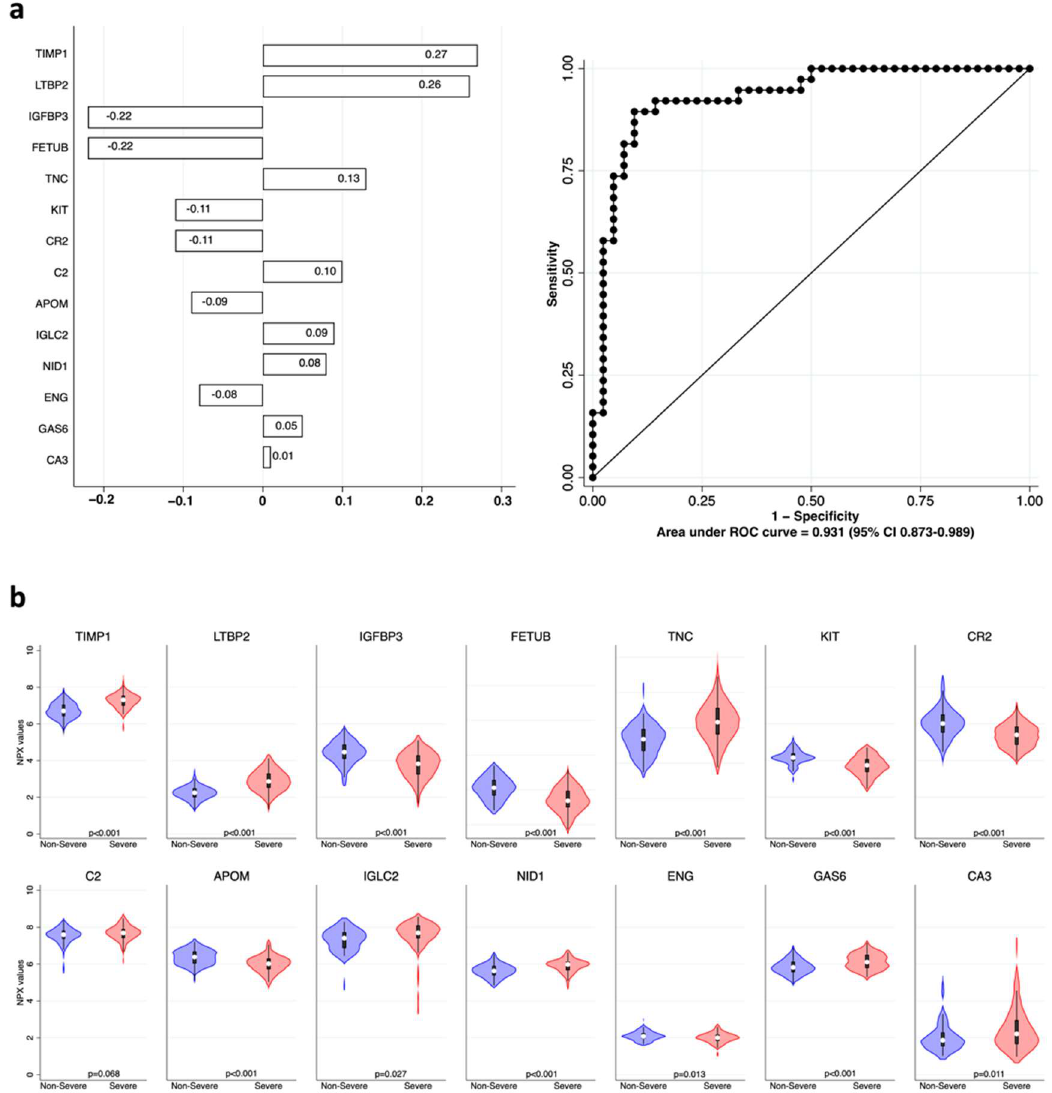
Figure 2. Cardiometabolic biomarkers associated with COVID-19 severity. ( a ) Elastic net logistic regression with cardiometabolic variables. Coefficients of each variable are shown in the left panel as horizontal bars. The right panel shows that the receiver operating characteristic (ROC) and area under the curve (AUC), with its 95% confidence interval (CI) of the model, are 0.931 (95% CI 0.873–0.989). ( b ) Violin plots showing the distribution of the normalized protein expression (NPX) values of each variable included in the model in “non-severe” (blue) vs. “severe” (red) patients; p values for each comparison are shown at the bottom of each plot.